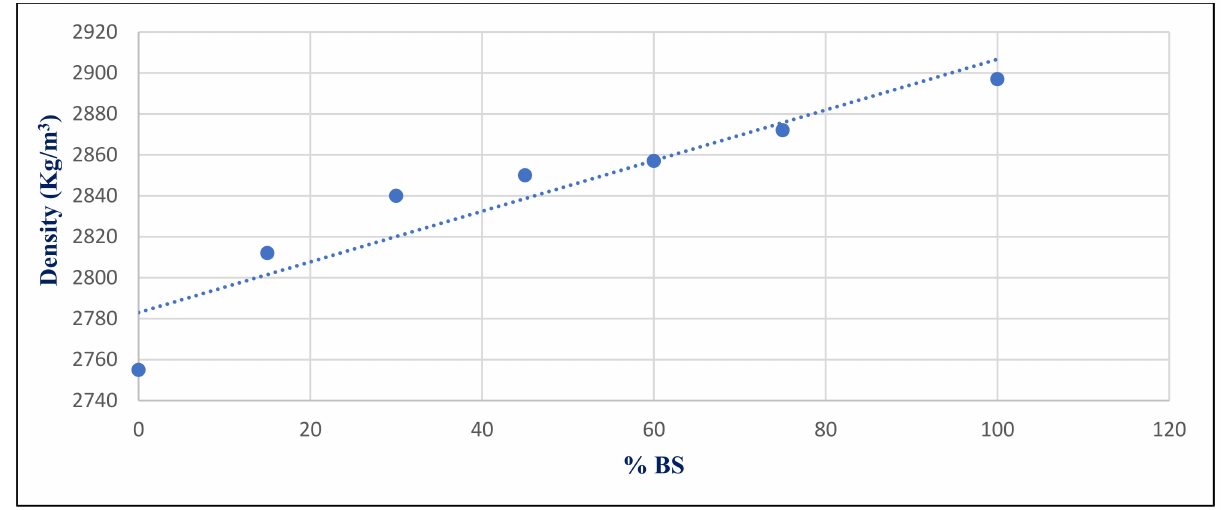
Figure 34. Correlation relation between %BS and density for group Z at day